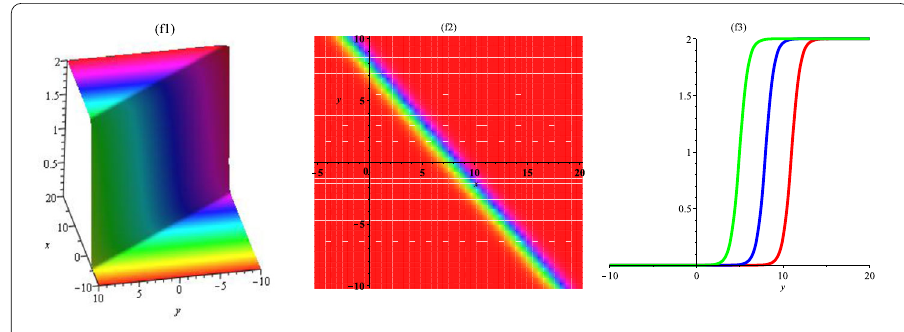
Figure 1 For solution of (2) u , v , c i = 1, t = 1, z = –10, (f1) 3D plot (f2) density plot and (f3) 2D plot with spaces x = –3,0,3